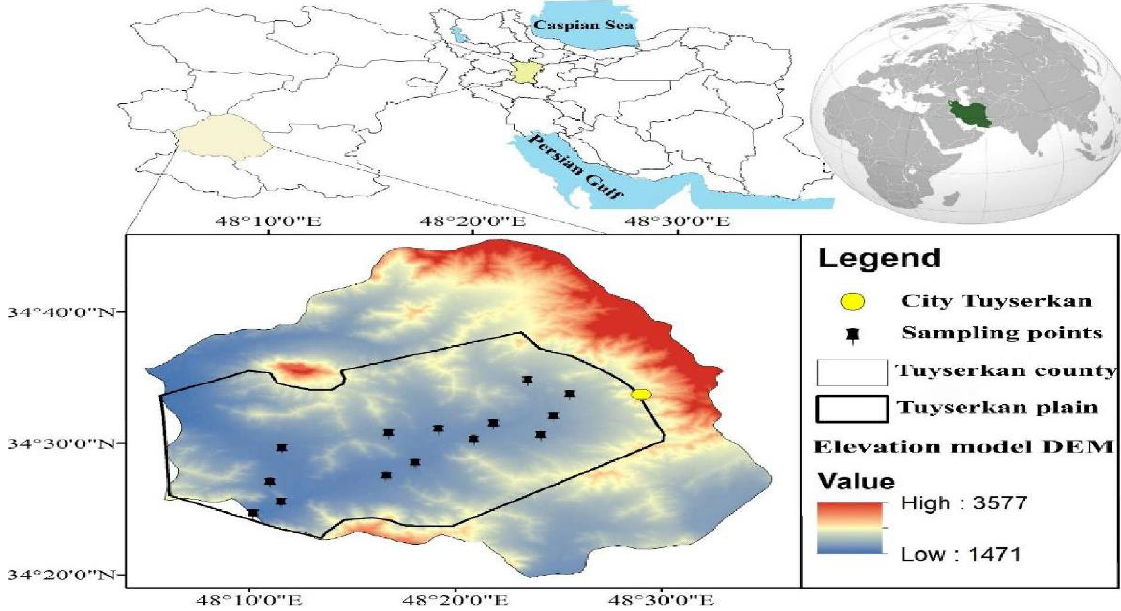
Fig. 1. Study area Table 1. Geographical characteristics of sampled wells in Tuyserkan